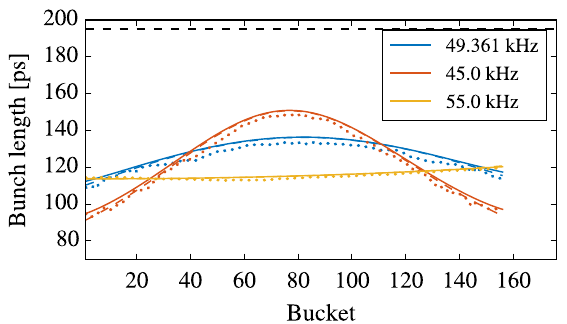
FIG. 11. Bunch length for a fill with 156 bunches for different tunings of the harmonic cavities for the matrix formulation (solid), F ILL P ATTERN S IM (dashed), and MBTRACK (dotted). The detuning of 49.361 kHz corresponds to flat potential conditions for a uniform fill. The analytical value for a uniform fill pattern (black dashed) is shown for comparison.